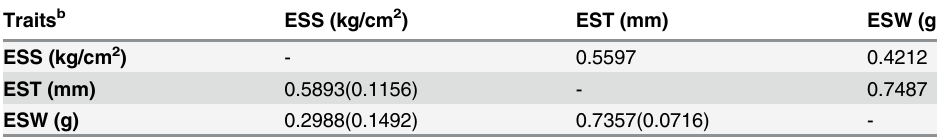
a Phenotypic correlations are given above diagonal, and genetic correlations below diagonal. Standard errors of estimates are in parentheses.